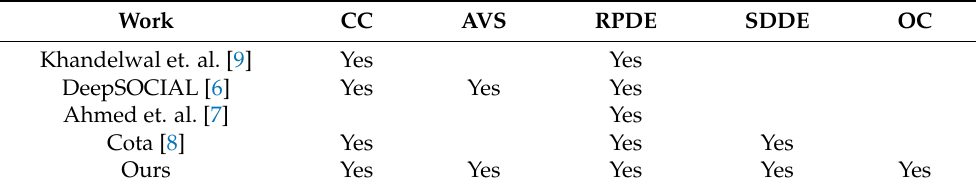
Table 1. Comparison of vision-based social distancing